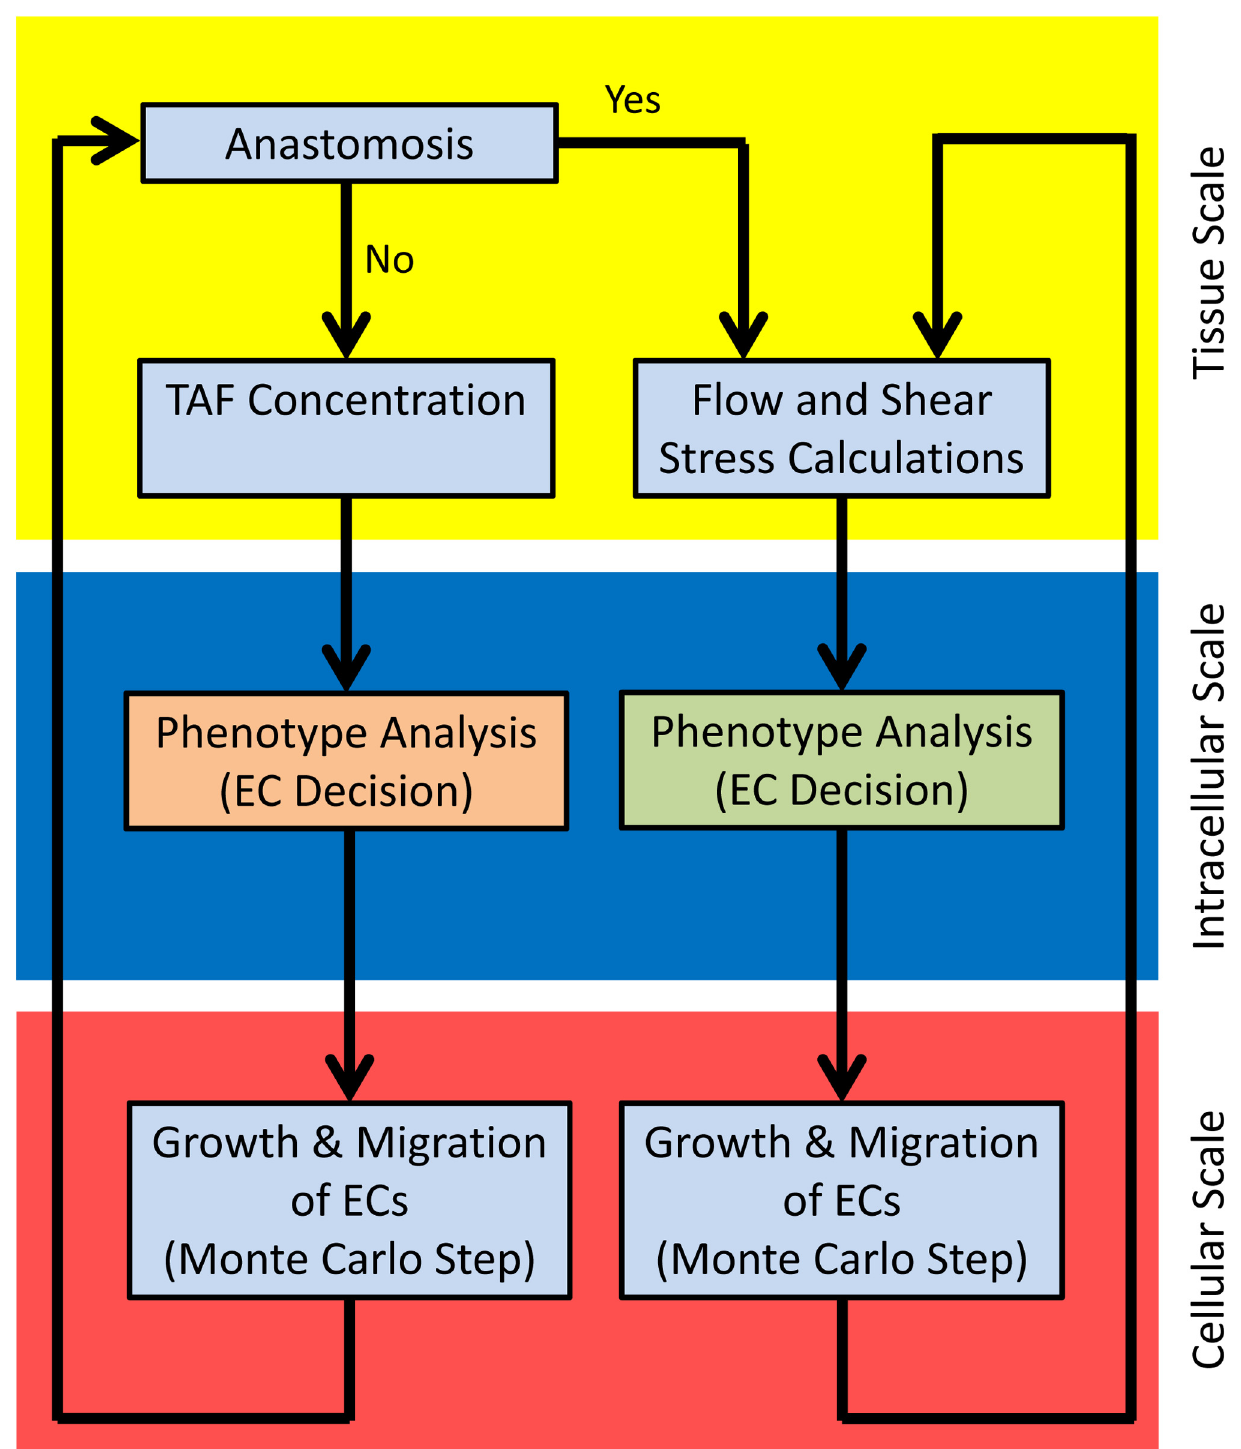
Fig 2. The solution procedure for the multiscale model. The yellow zone represents the tissue scale, the blue zone is intracellular (molecular) scale, and the red zone is cellular scale. In intracellular scale, different signaling cascades are used for EC phenotype determination before and after anastomosis. In cellular scale, growth and migration of ECs are calculated with similar formulation before and after anastomosis; however, the constants in the formulations depend on the predicted phenotype.